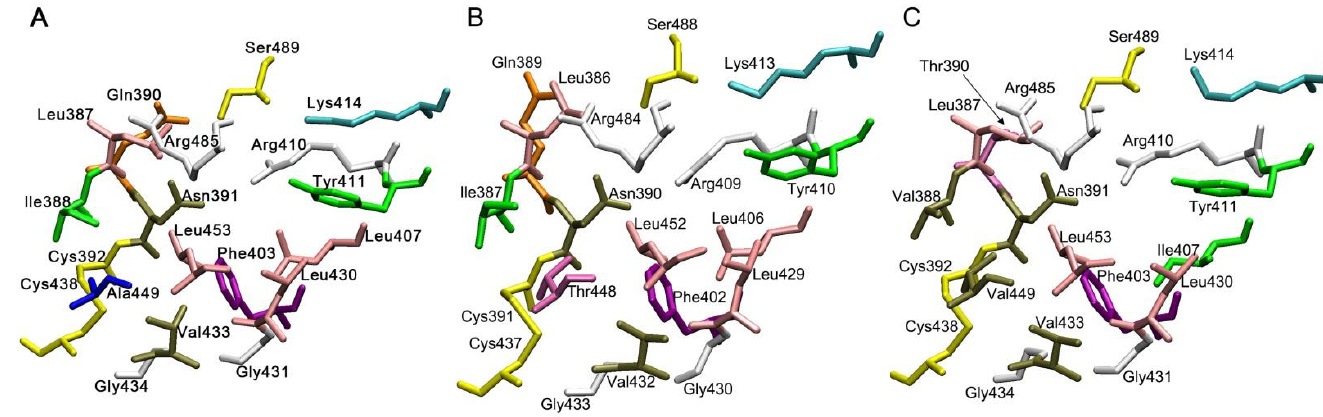
Figure 3. Structures of Sudlow site II of of HSA ( A ), BSA ( B ) and RSA ( C ).